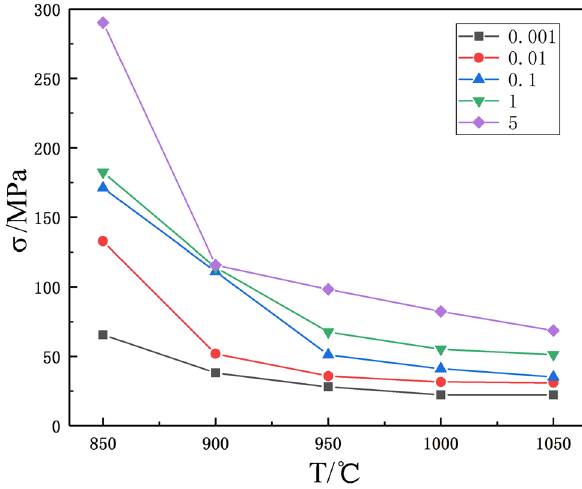
Figure 2: Curve of peak stress with temperature at di ff erent strain rates of TC4 titanium alloy during hot